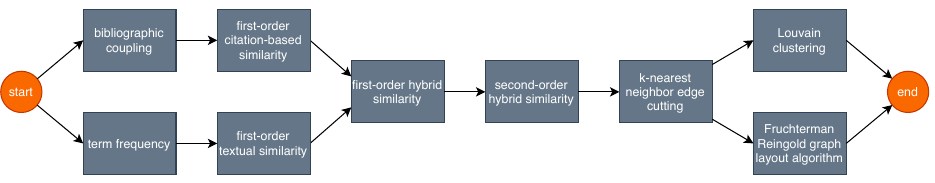
Figure 4. The process of computing and visualizing research